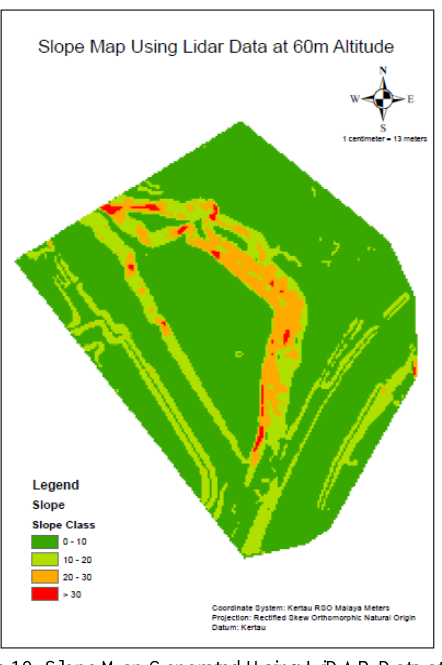
Figure 18. Slope Map Generated Using UAV Data at 60m Altitude